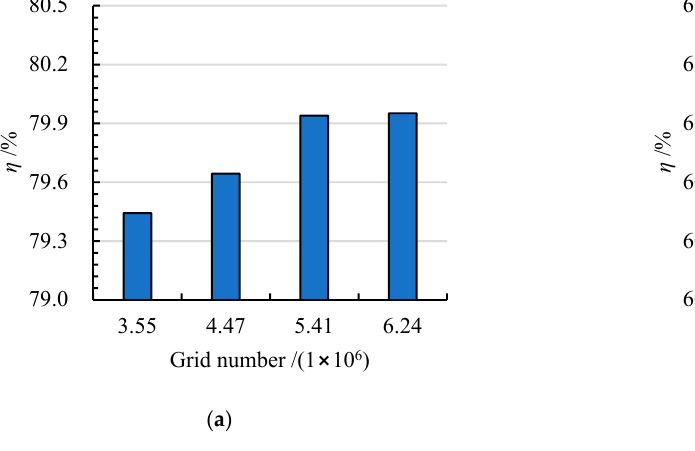
Figure 6. Grid independence analysis under ( a ) forward condition and ( b ) reverse condition.